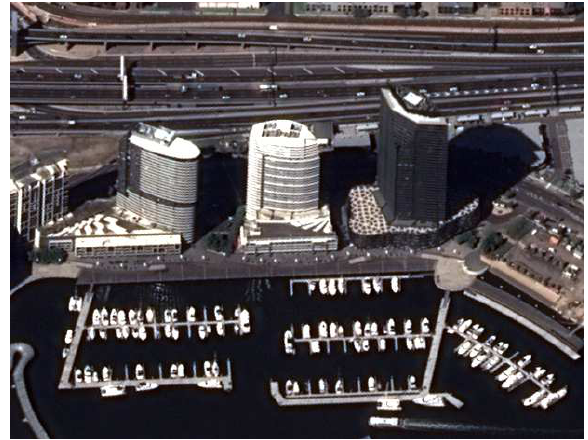
Figure 1 : Pleiades-HR image of Melbourne downtown,